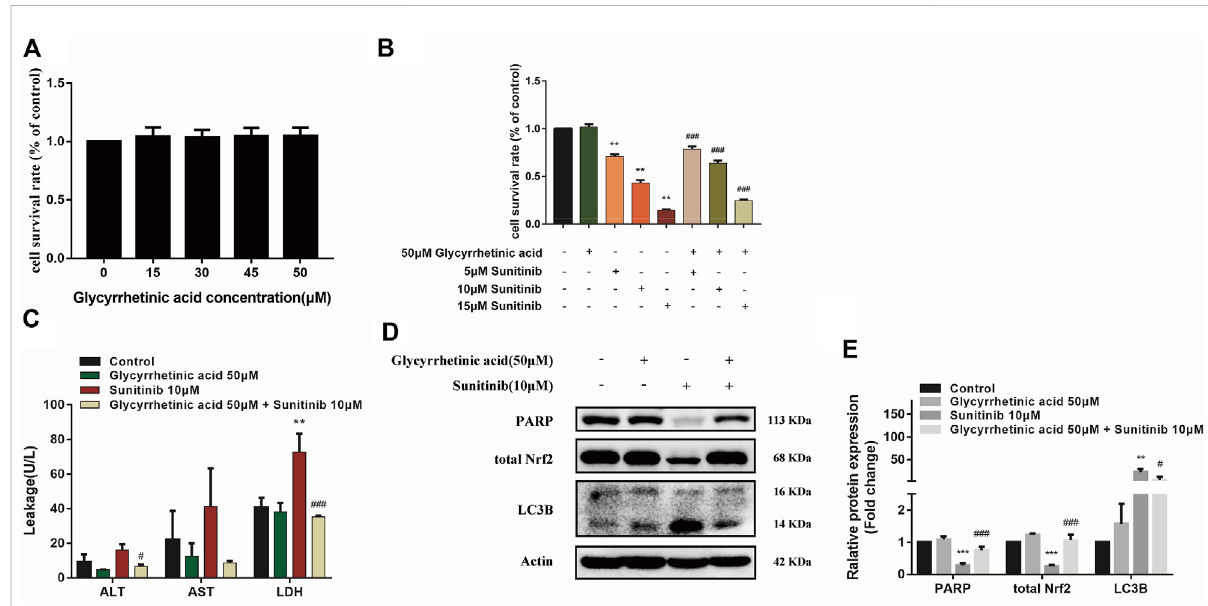
FIGURE 6 Glycyrrhetinic acid has protective effects against Sunitinib-induced hepatotoxicity. (A) Cytotoxicity of glycyrrhetinic acid at various concentrationfor6+48 hinL02cells( n =4 – 6). (B) TheviabilityofhepatocyteswasanalyzedbyMTTafterL02cellswereincubatedwith5,10,15 μ M Sunitinibfor48 hinthepresenceorabsenceof50 μ Mglycyrrhetinicacidpretreatmentfor6 h( n =6). (C) ALT,ASTandLDHlevelsinthesupernatant afterL02cellswereincubatedwith10 μ MSunitinibfor48 hinthepresenceorabsenceof50 μ Mglycyrrhetinicacidpretreatmentfor6 h( n =3). (D,E) LC3B levels in L02 cells after Sunitinib (10 μ M) for 48 h in the presence or absence of 50 μ M glycyrrhetinic acid pretreatment for 6 h ( n = 3). ** p < 0.01 and *** p < 0.001 vs. Control group. # p < 0.05, ## p < 0.01 and ### p < 0.001 vs. Sunitinib